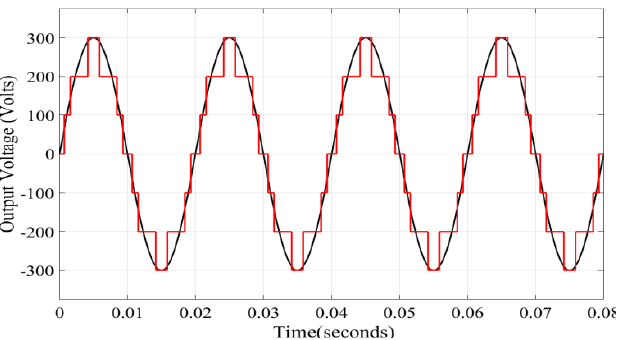
Figure 3. Seven− level MLI output voltage and fundamental component of output voltage both have Figure 3. Seven-level MLI output voltage and fundamental component of output voltage both have quarter wave symmetry. quarter wave symmetry.